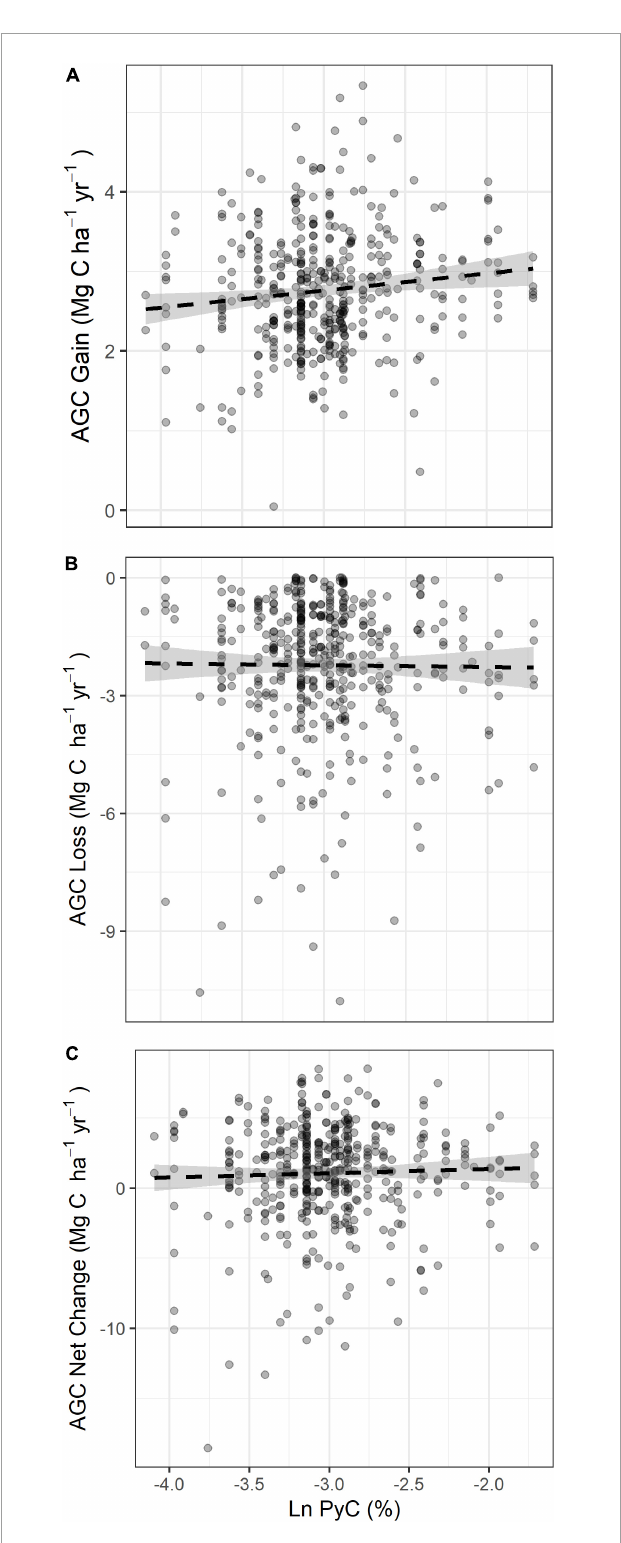
FIGURE4 Relationship between AGC dynamics and PyC (log-scale) for (A) AGC gains, (B) AGC losses and (C) AGC net change. Dashed lines represent non-significant relationships between variables and the shading denotes the 95% confidence interval from our GLMM.